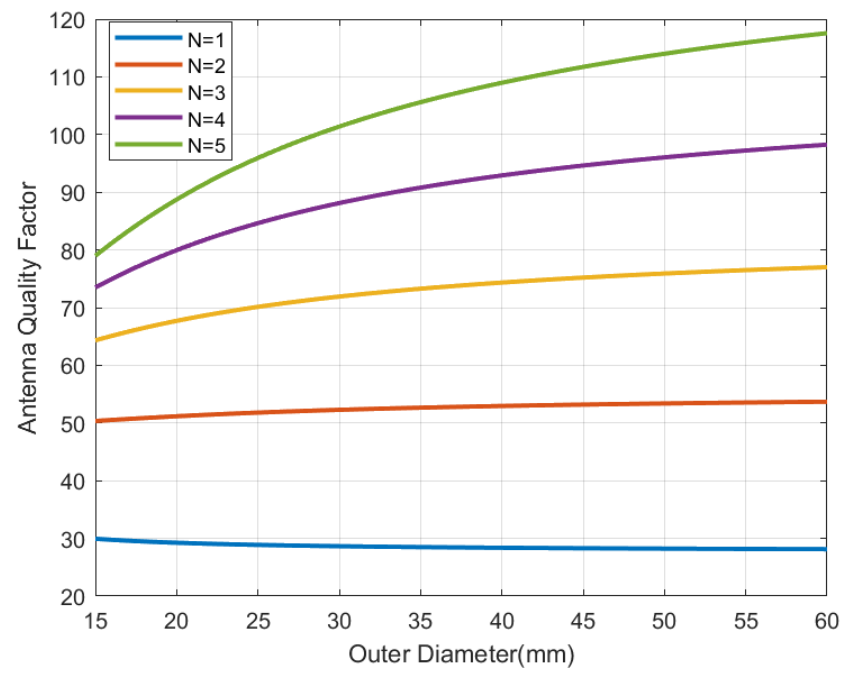
Figure 7. Simulated antenna quality factor as a function of the outer diameter for a square antenna with a different number of turns.